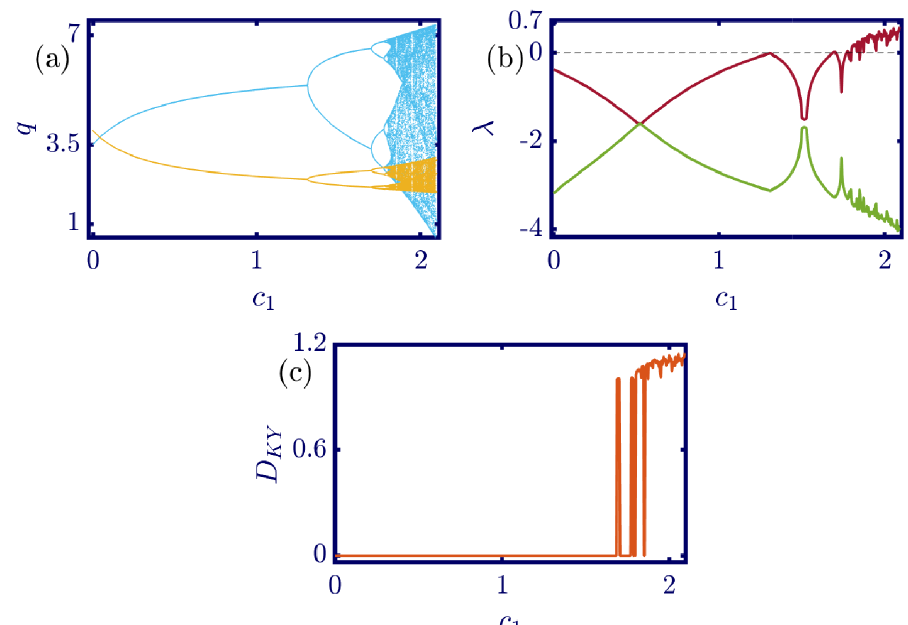
Fig 5. Eq (13) dynamics concerning the parameter c 1 with a = 6, b = 0.5, c 2 = 1, d 1 = 0.5, d 2 = 1, v 1 = 0.1, v 2 = 1 and initial conditions q 1 (0) = q 2 (0) = 1. (a) Bifurcation diagram, (b) Lyapunov exponents spectra, and (c) Kaplan-Yorke dimension. By increasing the cost coefficient, the difference between the planned and current amount of production becomes more significant. This un-organization in planning the company’s manufacturing strategy results in a chaotic and uncontrollable market. In the sub-figure (a), the cyan points represent the data for the leader firm ( q 1 ), whereas, the yellow points represent those for the follower firm ( q 2 ), and in sub-figure (b), the red and green points present the Lyapunov exponent spectra for the leader and follower firms respectively, namely λ 1 and λ 2 .